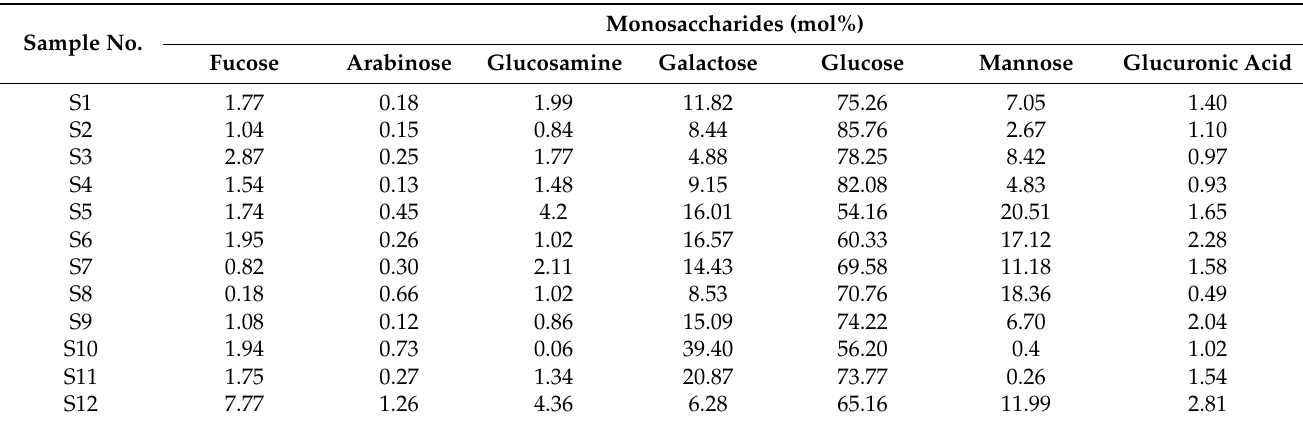
Table 2. Monosaccharide composition and molar ratio of polysaccharides.